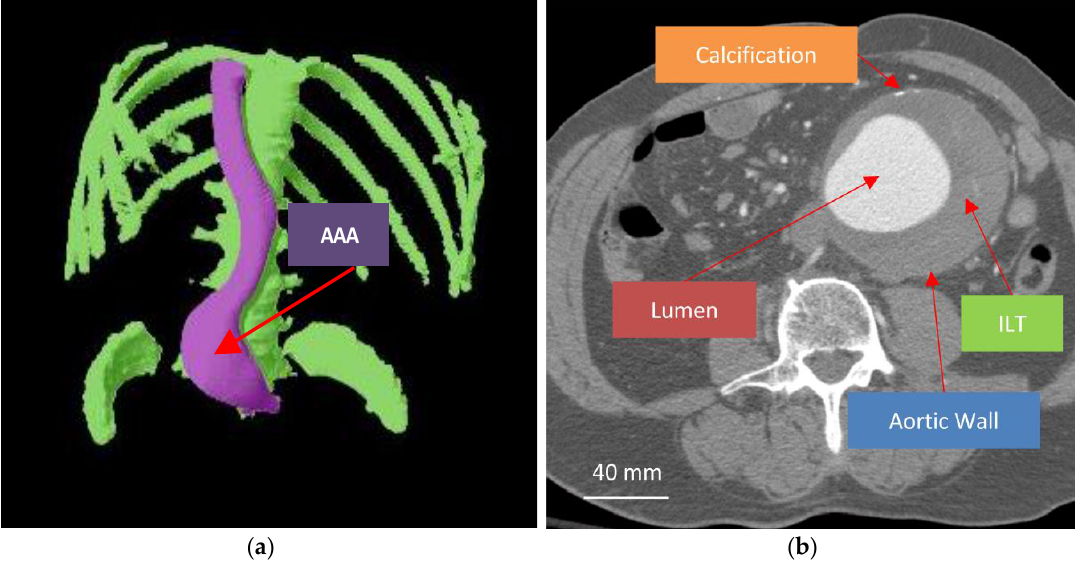
Figure 1. Abdominal aortic aneurysm (AAA). ( a ) Three-dimensional rendering of the aorta, with an AAA, and the vertebra, rib cage, and hip bones for reference. ( b ) Annotated transverse CT scan section illustrating the AAA lumen, intraluminal thrombus (ILT), and aortic wall with calcification. Note: from this CT image, aortic wall thickness cannot be determined.